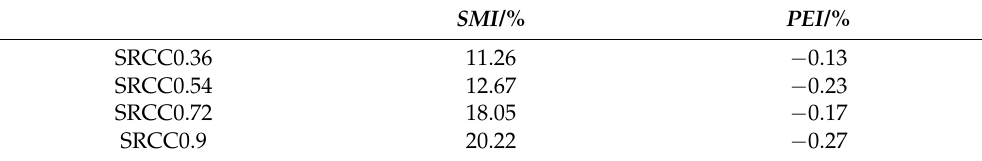
Table 3. SMI and PEI of self-circulating casings with different circumferential coverage ratios. SMI /% PEI